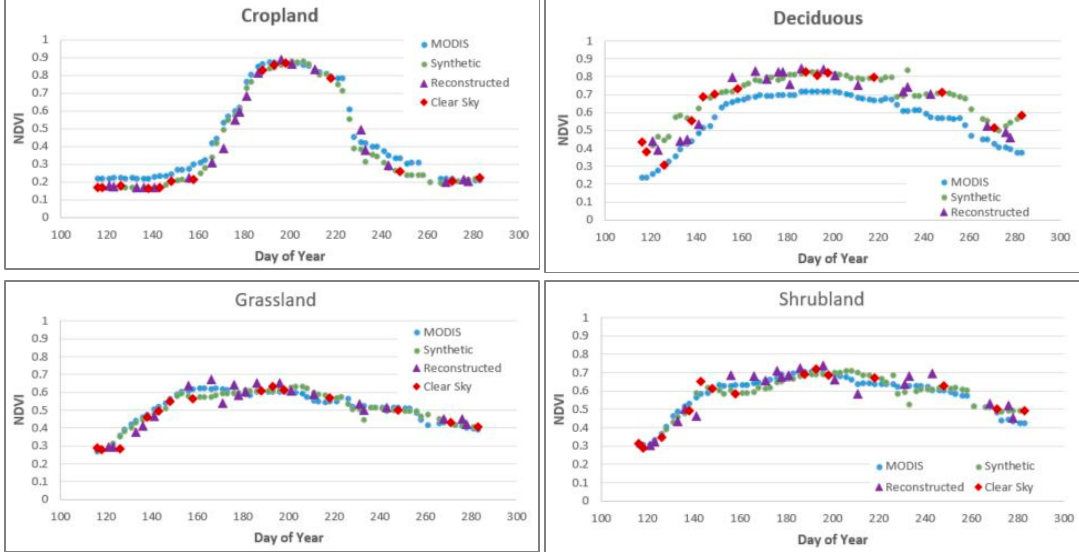
Figure 10. The Normalized Di ff erence Vegetation Index (NDVI) time-series of vegetation: upper left: Cropland; upper right: Deciduous forest; lower left: Grassland; and lower right: Shrubland.